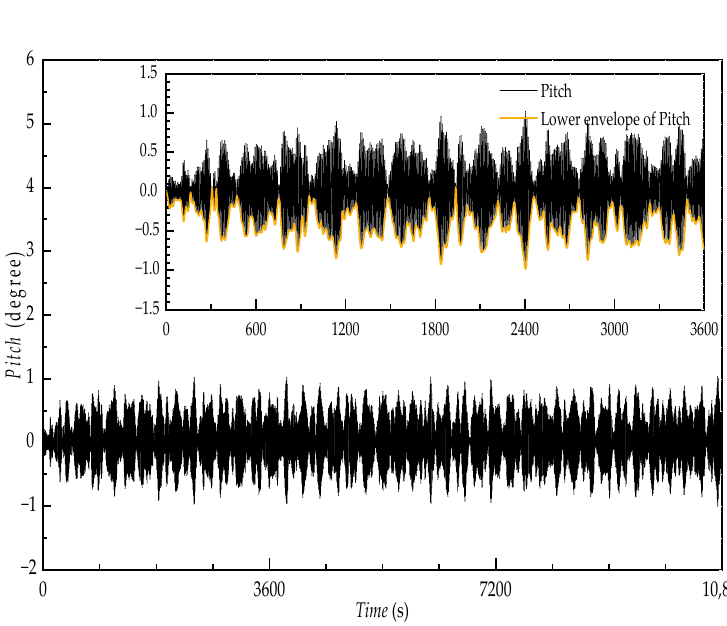
Figure 8. Pitch in 3 h duration.